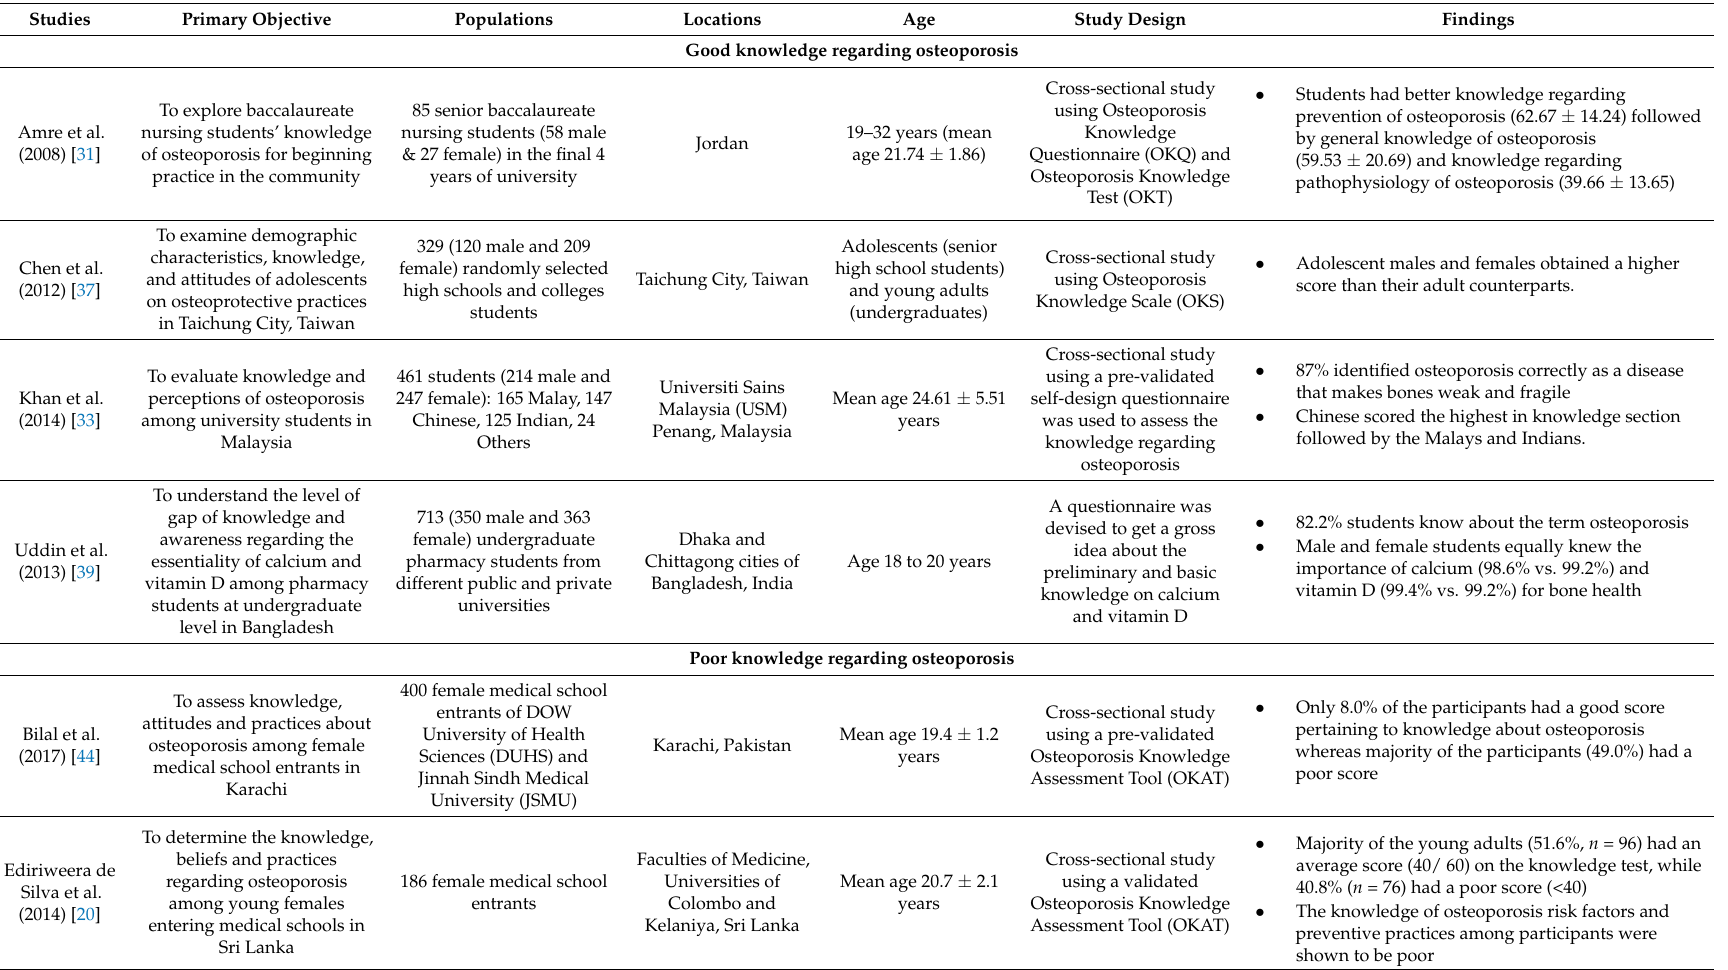
Table 1. Knowledge regarding osteoporosis among adolescents and young